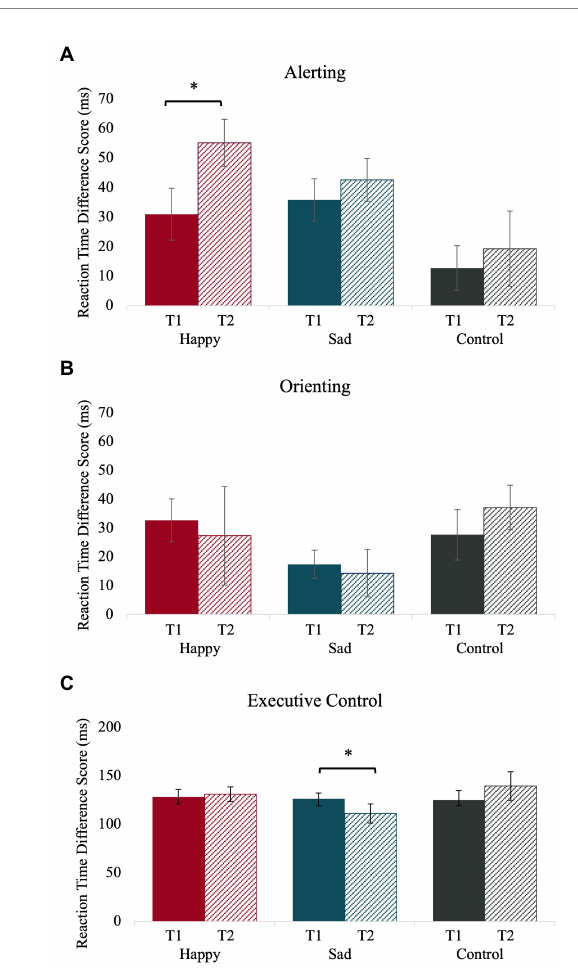
FIGURE 3 Changes in alerting (A) reaction time difference score for no cue– double cue, orienting (B) reaction time difference score for center cue–valid spatial cue, and executive control (C) reaction time difference score for incongruent–neutral trials from time one (T1) to time two (T2) within each group. Error bars represent ± 1 standard error. Alerting improved from time one to time two for the happy music group only. Executive control improved from time one to time two for the sad music group only.